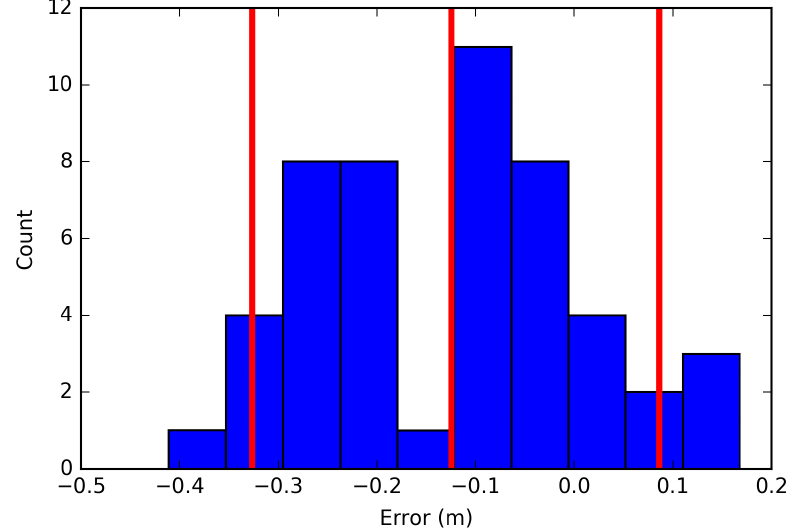
Figure 1. Histogram showing the elevation error and the location of the representative values (red): mean = − 0.12, standard deviation =